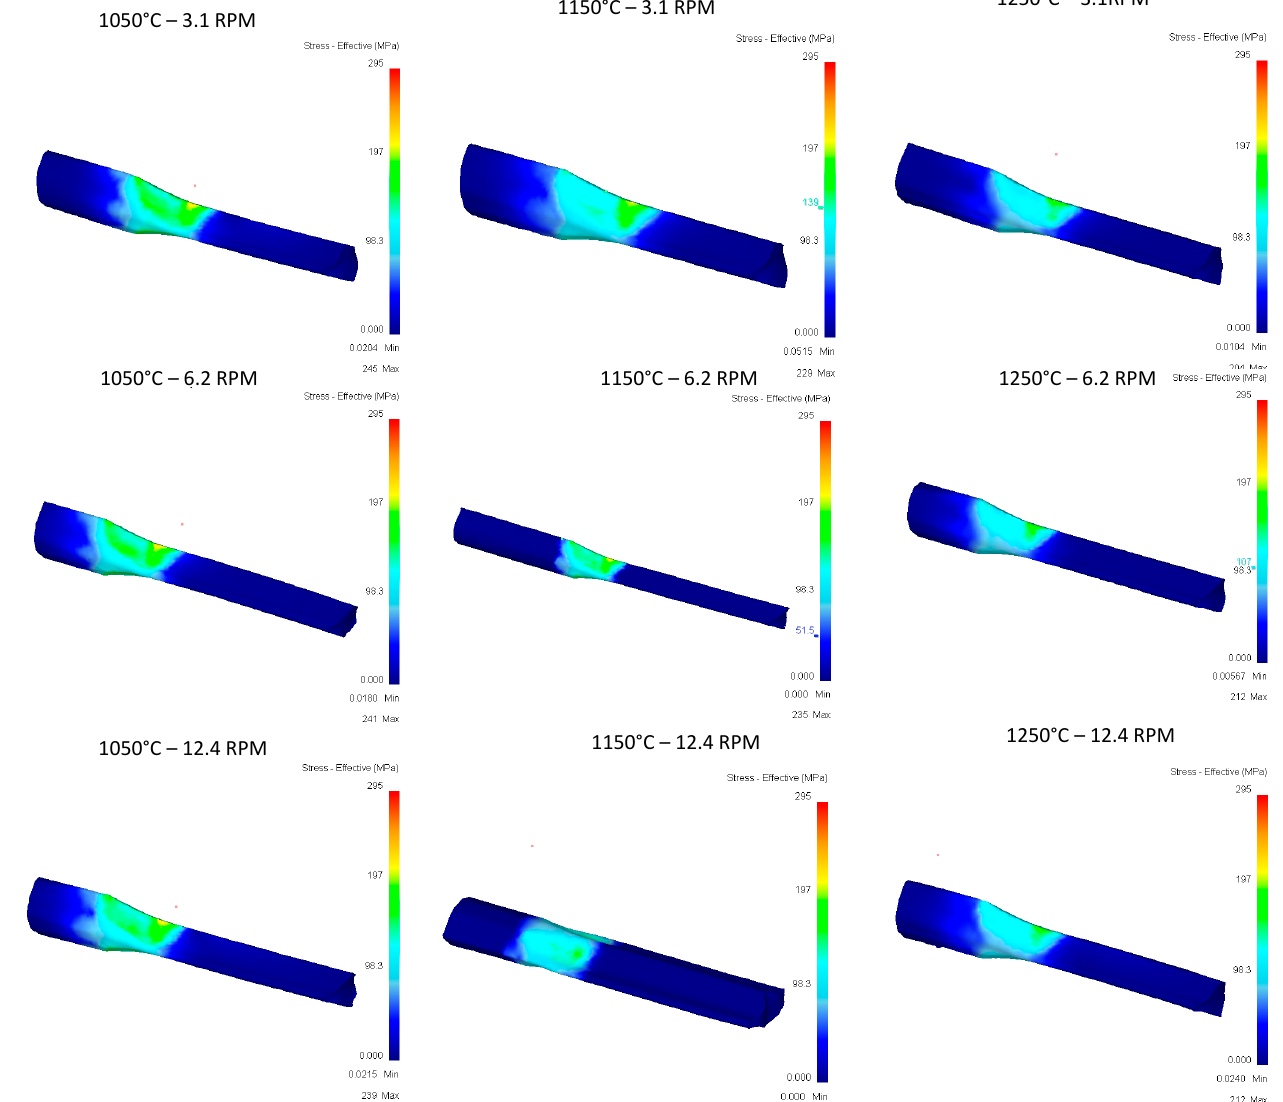
Figure 19. Effective stress in the top Rail after fourth pass.